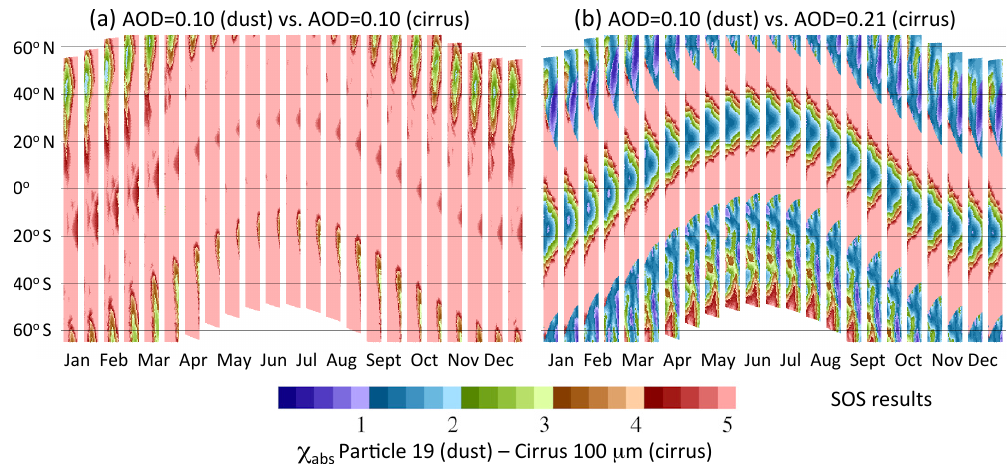
Fig. 17. Same as Fig. 16, but comparing an atmosphere with MISR Particle 19 with an atmosphere containing the cirrus model with D e = 100µm. (a) AOD=0.1 for both aerosol models, (b) AOD=0.1 for Particle 19, and AOD=0.21 for the cirrus